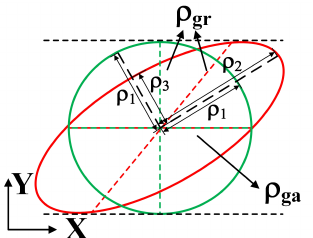
Figure 4. The − 3 dB resolution ellipses of constant-parameter SAR and parameter-adjusting SAR in the EHS geometry. The red and green ellipses represent the resolution ellipses of constant-parameter case and parameter-adjusting case,